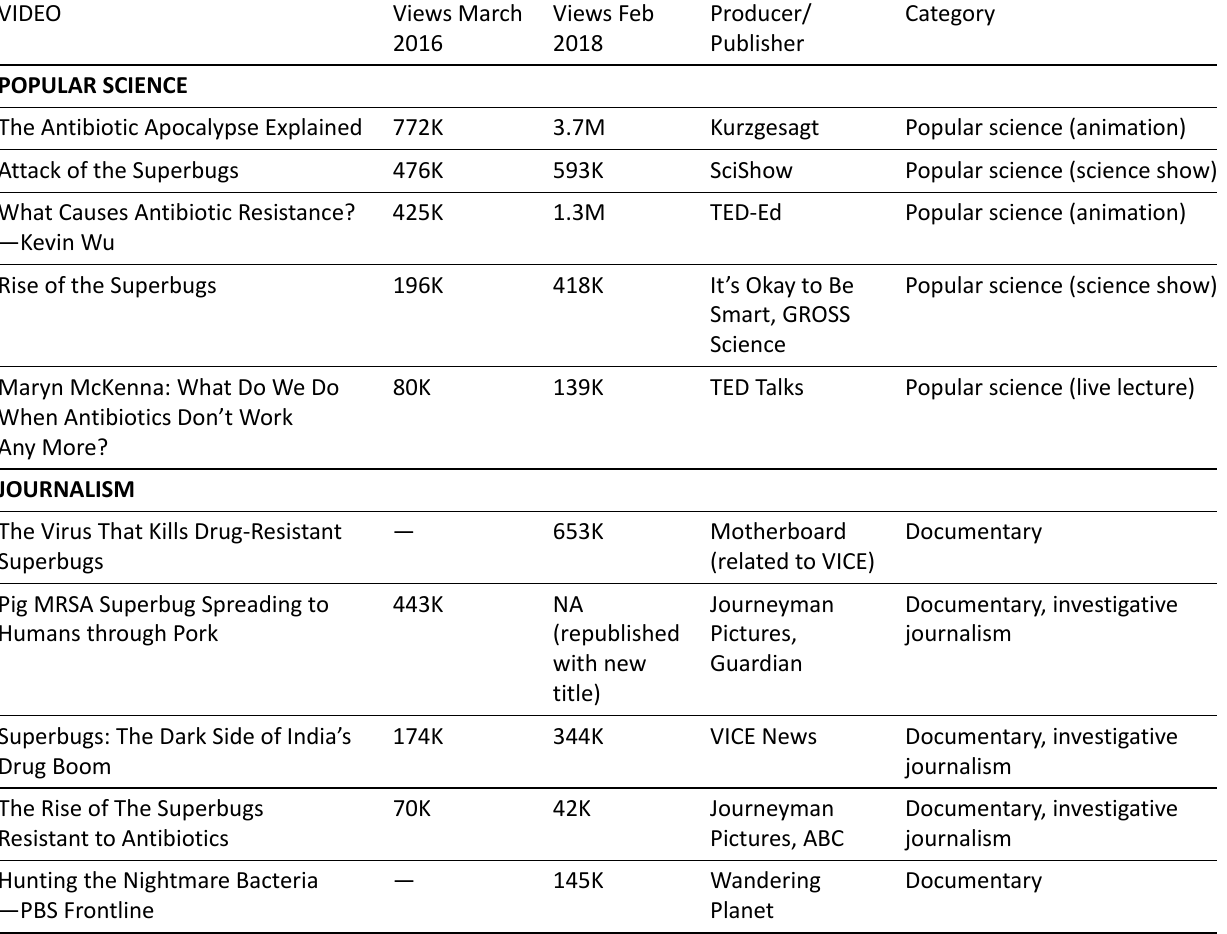
Table 1. Sample of videos.